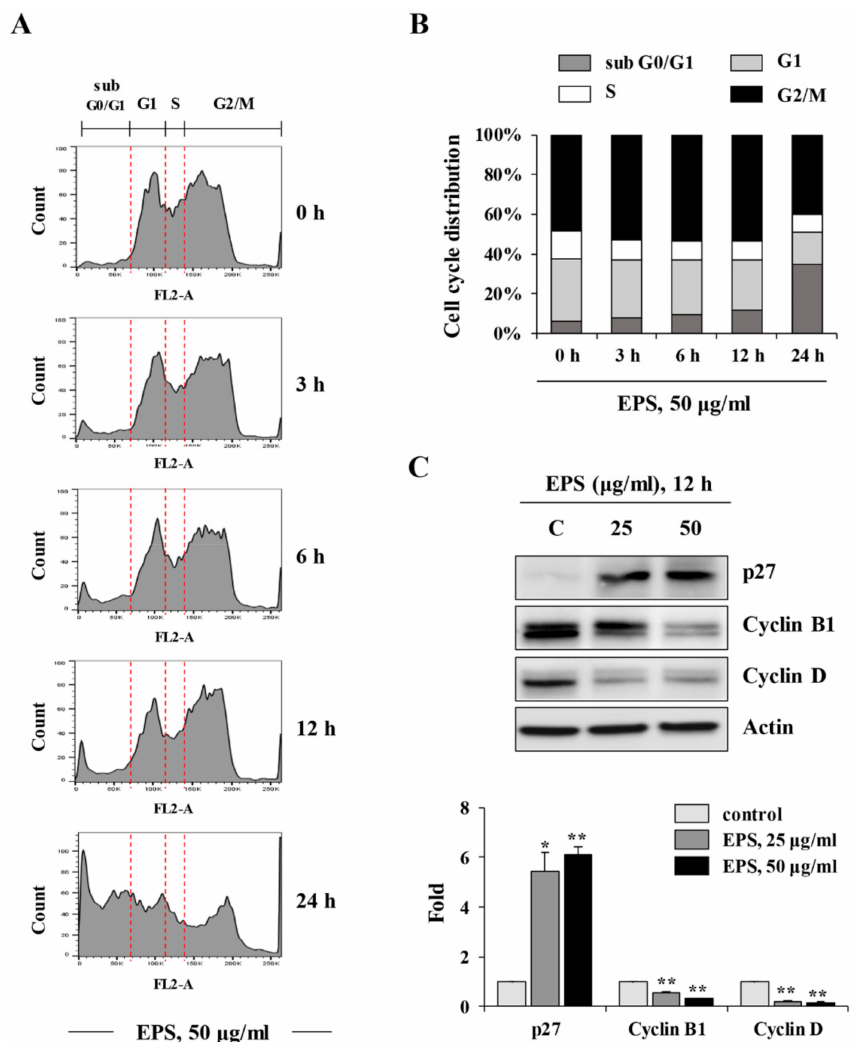
Figure 2. EPS induces cell cycle arrest at the G2 / M phase in hiPSCs. ( A , B ) hiPSCs were incubated with 50 µ g / mL EPS for 3, 6, and 12 h, and then cell cycle distribution was analyzed using flow cytometry after staining intracellular DNA with propidium iodide (PI) solution. ( C ) The levels of cell cycle-related proteins in hiPSCs were measured by Western blotting after treating with indicated concentrations of EPS for 12 h. Relative band intensities compared with EPS-untreated control hiPSCs were calculated using Image J software after normalization to actin expression. * p < 0.05 and ** p < 0.01 vs. EPS-untreated